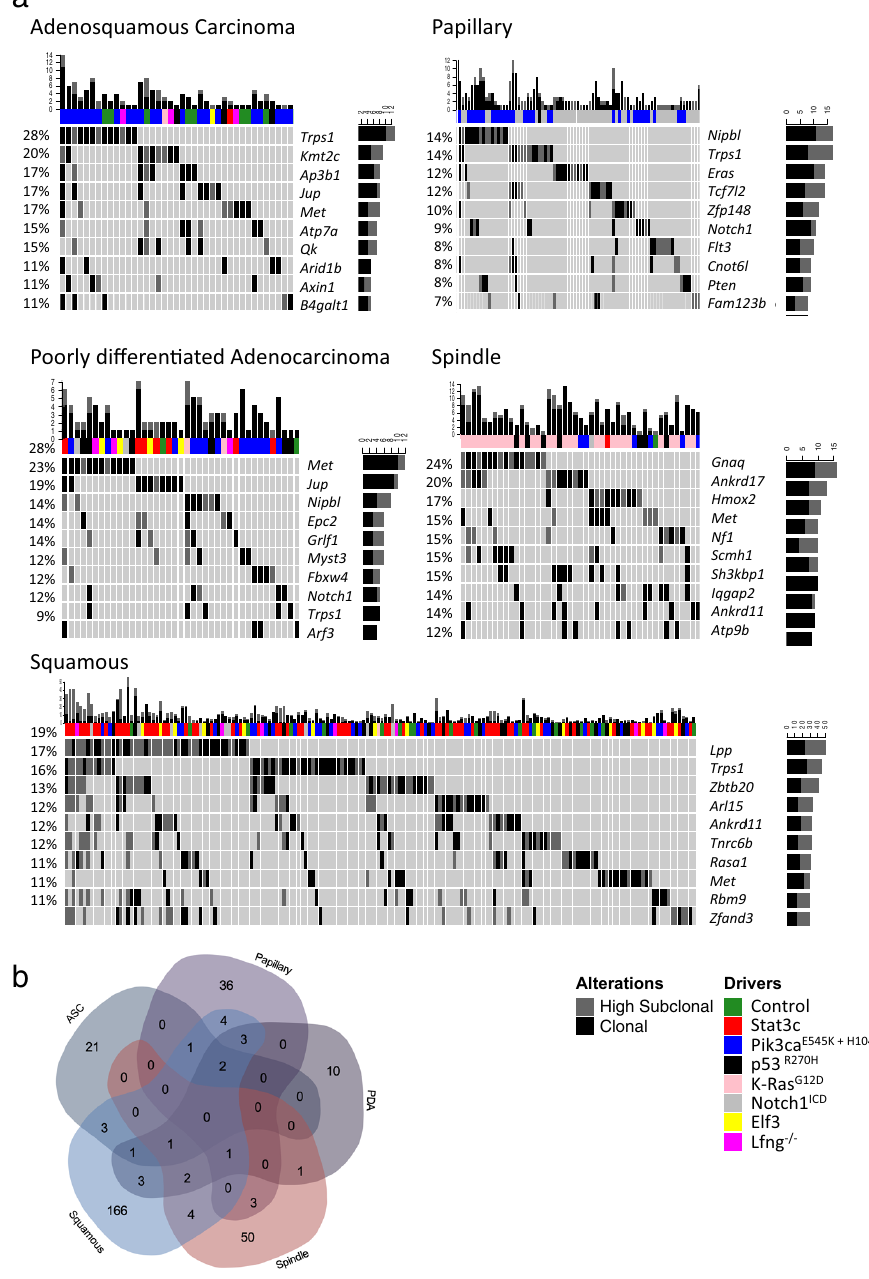
Fig. 4 SB insertion site analysis on the basis of histology de fi ned cohorts. a Top gCIS identi fi ed in histology-based cohorts. The genetic background of each tumor is color-coded as indicated. Top 10 gCIS are shown for each. Note, the percentage of tumors with each gene targeted by SB is shown on the y-axis to the left for each bar graph, the number of tumors with clonal vs. subclonal SB targeting by SB is shown on the y -axis to the right, whereas the number of identi fi ed gCIS in each tumor is shown on the x -axis above each bar graph. Note, control tumors (in green) are those which developed in SB alone mice without a genetically engineered initiating event. b Venn diagram depicting the overlap of clonal gCISs identi fi ed in each histopathologic